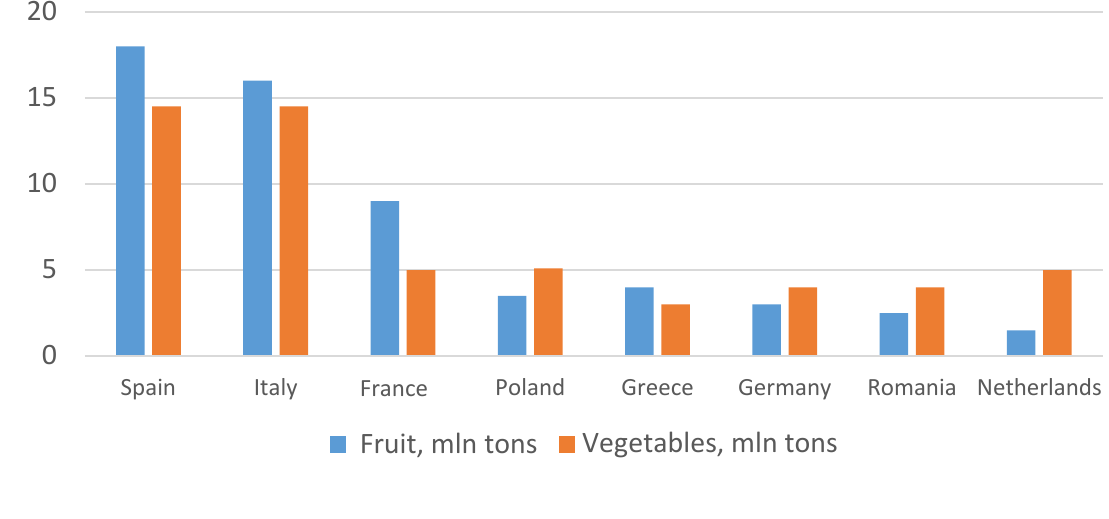
Figure 2. Vegetable production in European countries